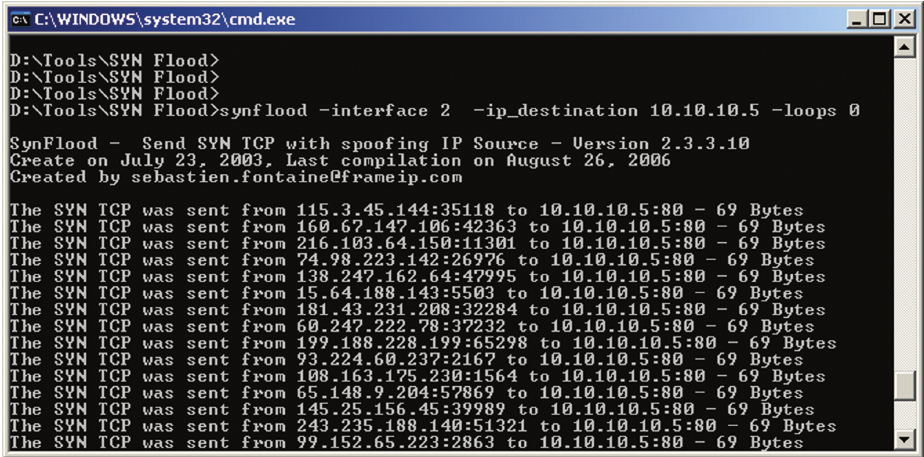
Figure 12. The SYN Flood Attack Online Command.